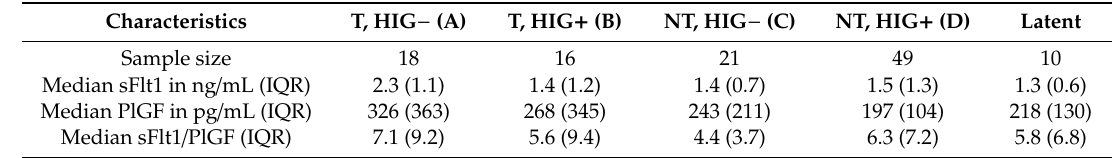
Table 2. Serum protein concentrations of sFlt1 and PlGF and sFlt1/PlGF ratio in subcohorts. Characteristics